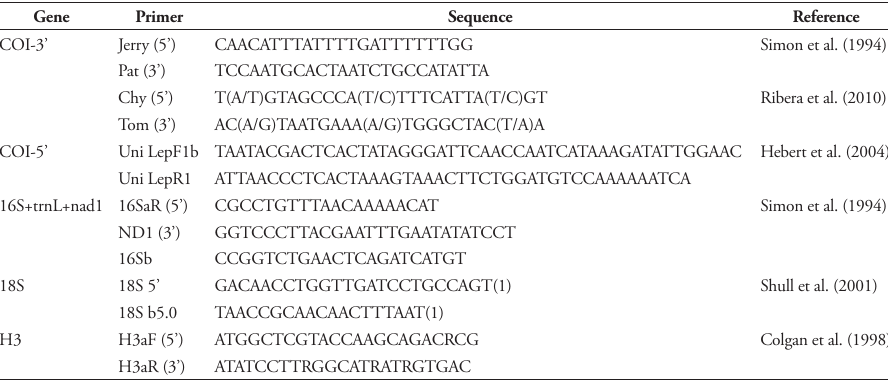
Table 2. Primers used in the amplifying and sequencing